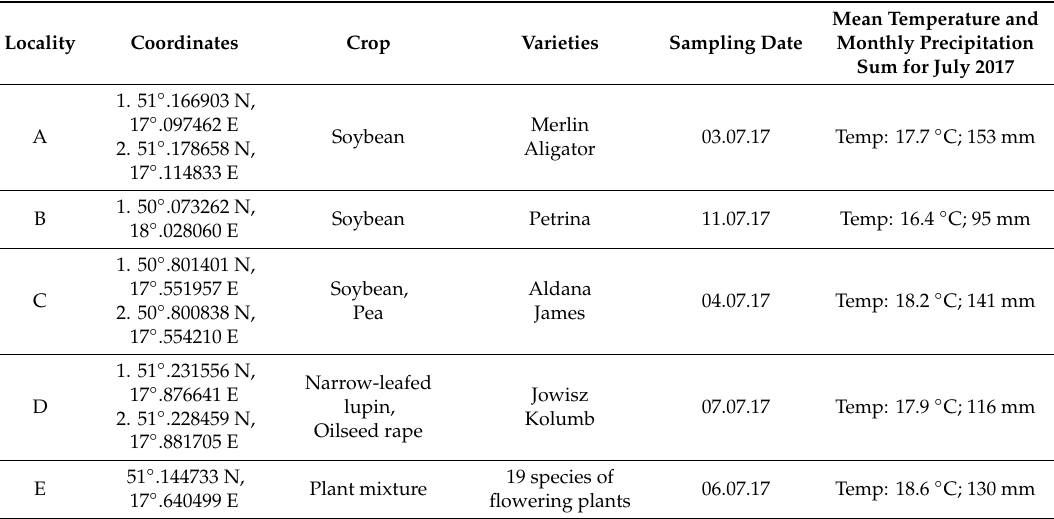
Table 1. The characteristic of localities and host